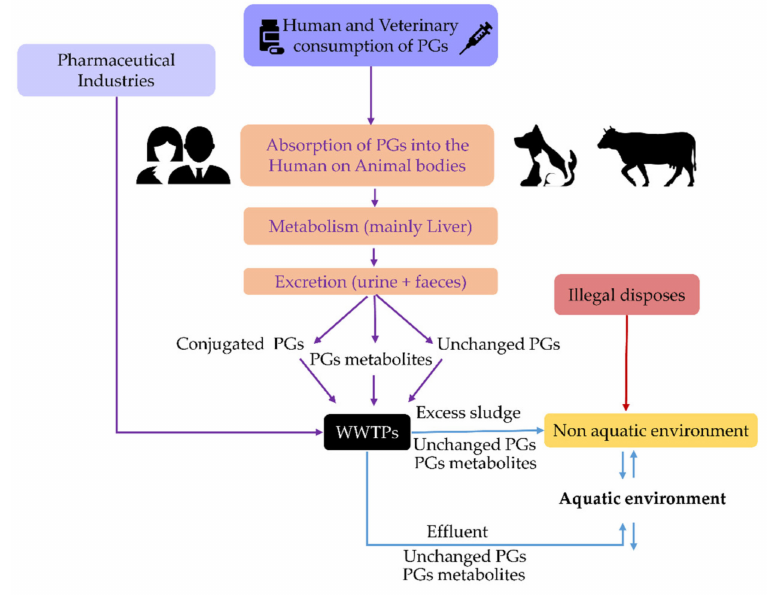
Figure 3. Sources and pathways for the occurrence of progestins in the environment. The distributions of PGs were based on Besse and Garric (2009)